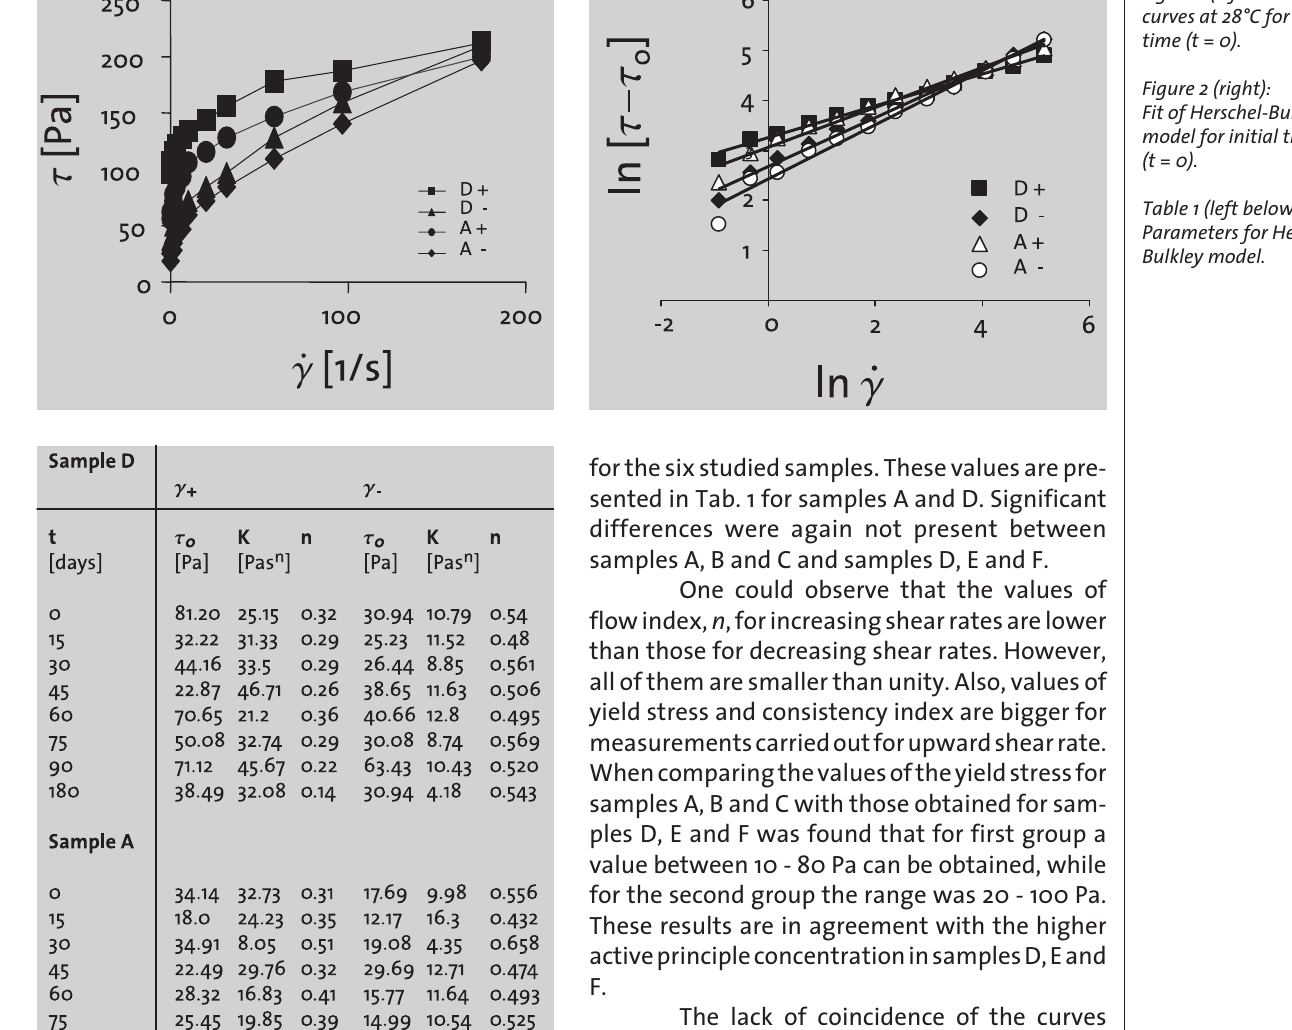
Figure 1 (left above): Flow curves at 28°C for initial time (t = 0). Figure 2 (right): Fit of Herschel-Bulkley model for initial time (t = 0). Table 1 (left below): Parameters for Herschel- Bulkley